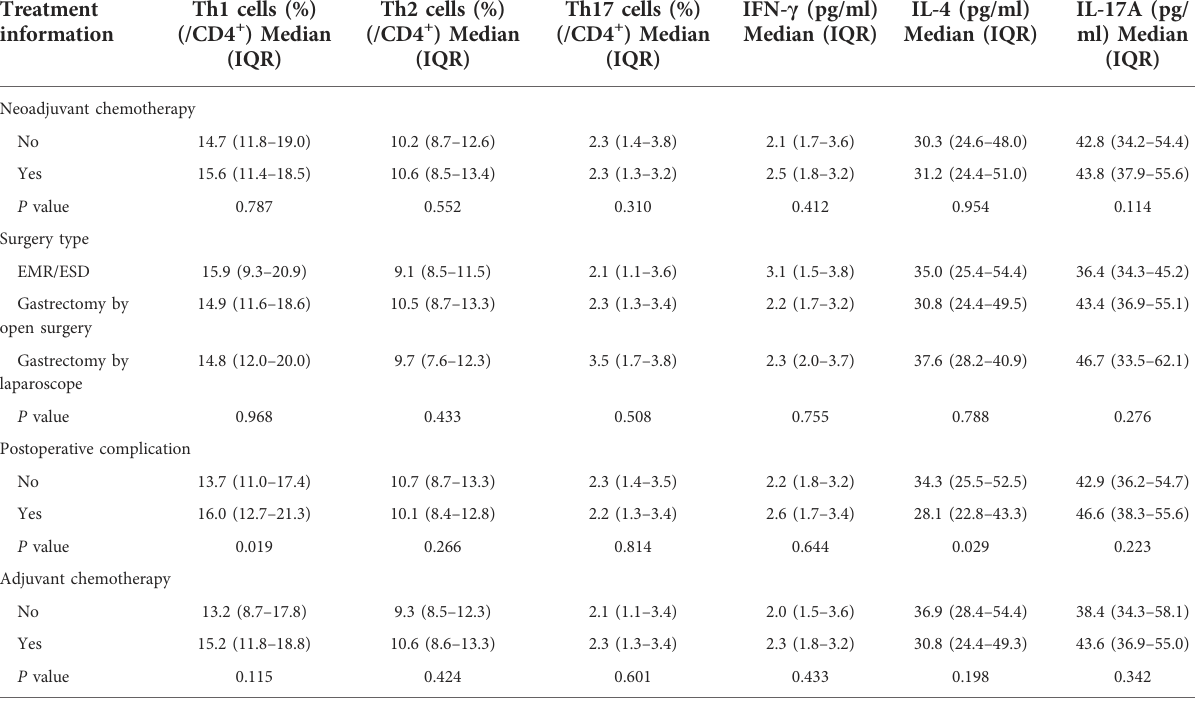
TABLE 5 Correlation of treatment information with Th cells and cytokines. Treatment